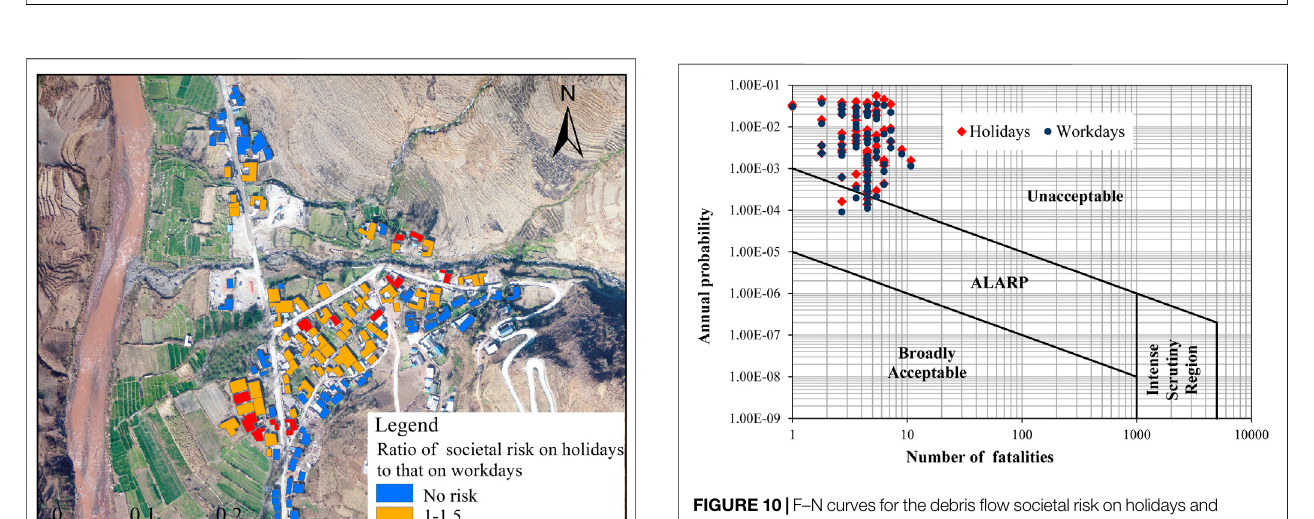
FIGURE 8 | Societal risk map on workdays in Luomo